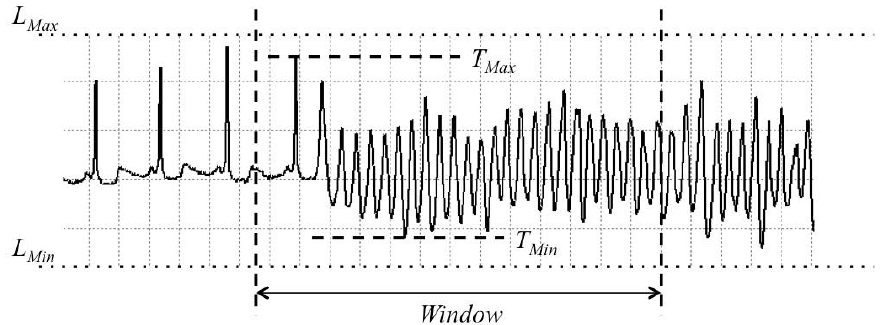
Figure 3. An example of the scaling process.